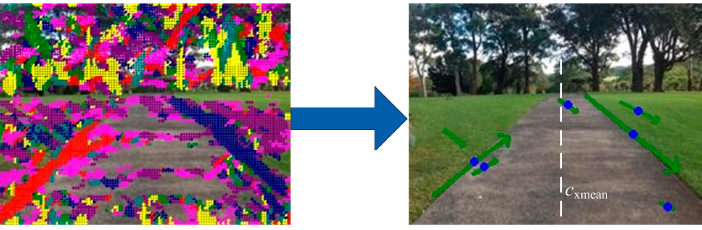
Figure 2. An example of grouping dominant pixels into line segment candidates. Left: image overlaid with texture orientations, 22.5°-pink, 45°-red, 67.5°-cyan, 90°-yellow, 112.5°-green, 135°-deep blue, 157.5°-purple. Right: selected line segment candidates (arrowed green lines with blue points in the middle); the one on the most left is abandoned.